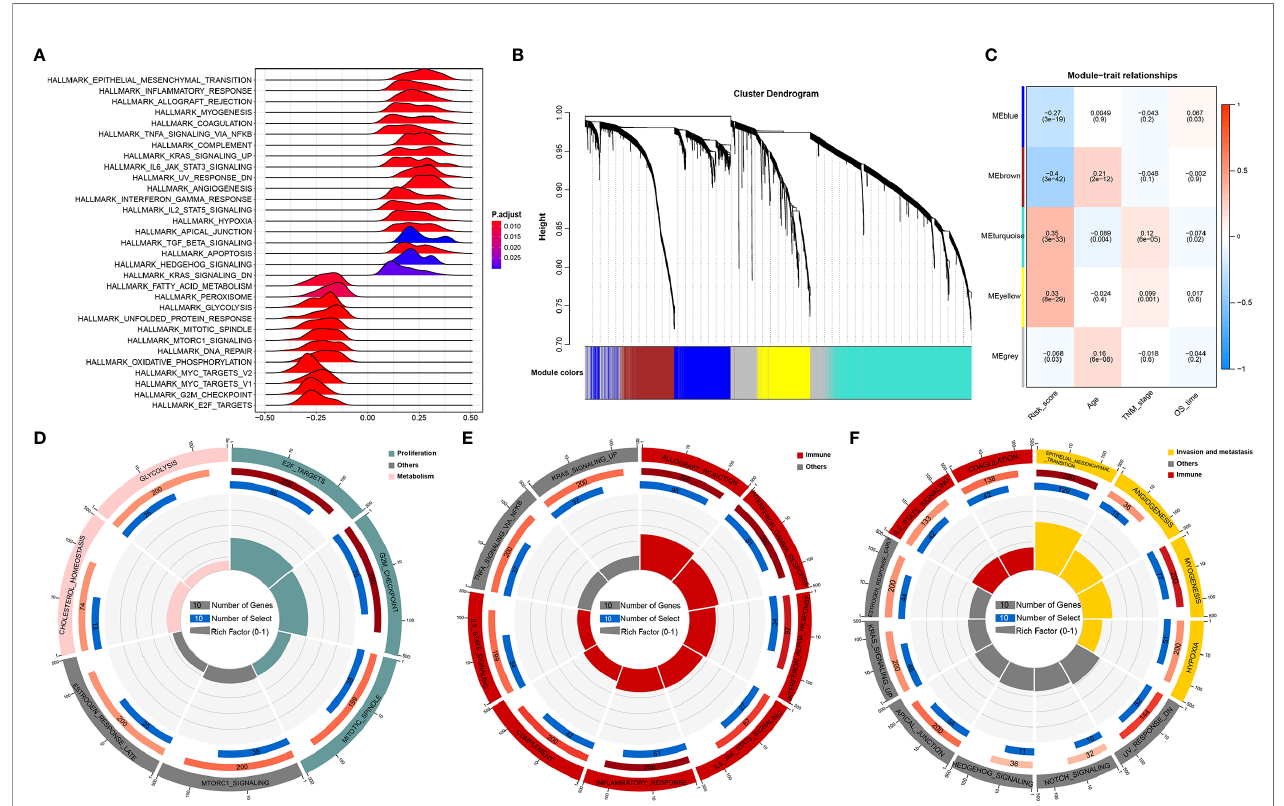
FIGURE 4 | Function analysis of genes correlated with the RNA processing-related prognostic signature. (A) GSEA of the hallmark gene sets for risk scores based on pre-ranked Pearson ’ s correlation coef fi cients of risk score-associated mRNAs. (B) Clustering dendrogram of the top 5000 mRNAs with dissimilarity based on the topological overlap together with assigned module colors. (C) Module – trait relationships. Each row shows a module eigengene; each column corresponds to a clinical trait. Each cell contains the corresponding correlation (upper number) and p-value (lower number). (D – F) Functional enrichment analysis of the hallmark gene sets for the brown (D) , yellow (E) , and turquoise (F)